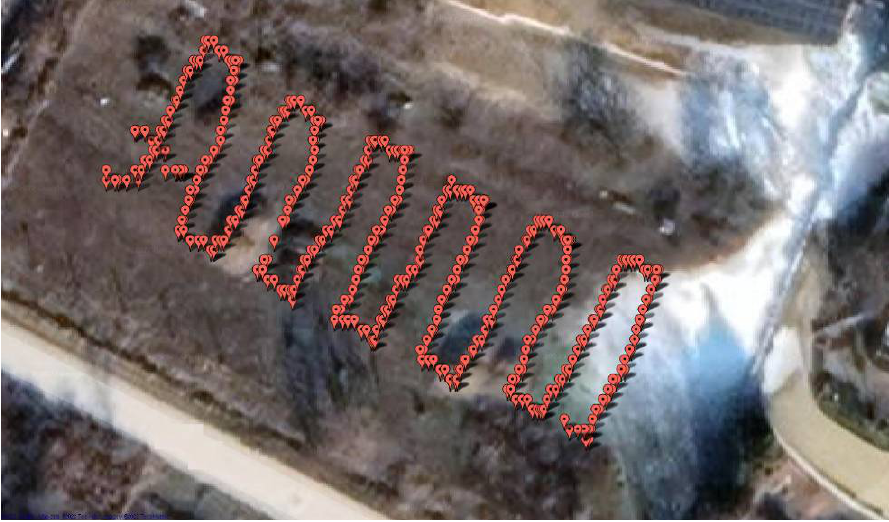
Figure 6. The screen of the processing software displaying raw measurement points.